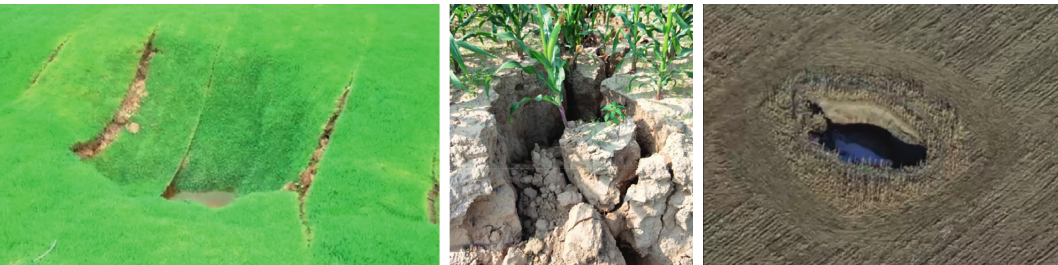
Figure 1: Land degradation due to underground